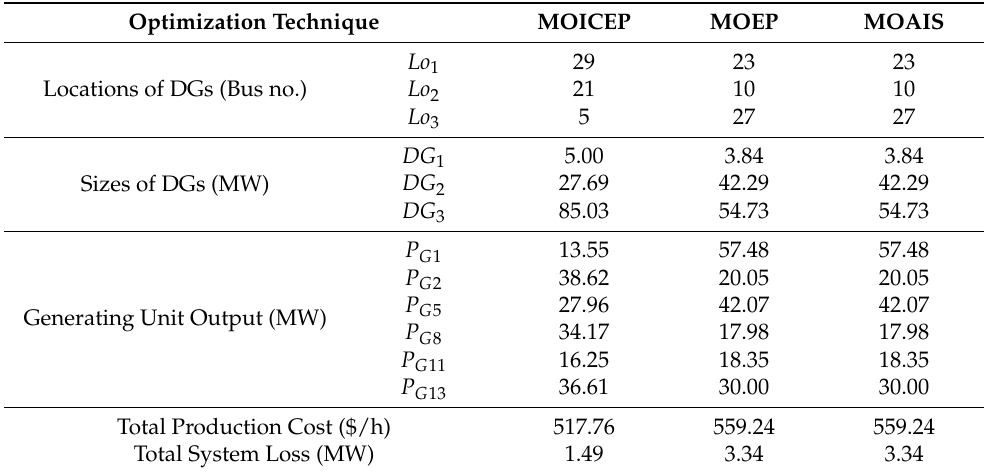
Table 14. Results of the integrated ED problem with prohibited operating zones and DG installation of the IEEE 30-Bus RTS ( w 1 = 0.1 and w 2 = 0.9). Optimization Technique MOICEP MOEP MOAIS Lo 1 Locations of DGs (Bus no.)